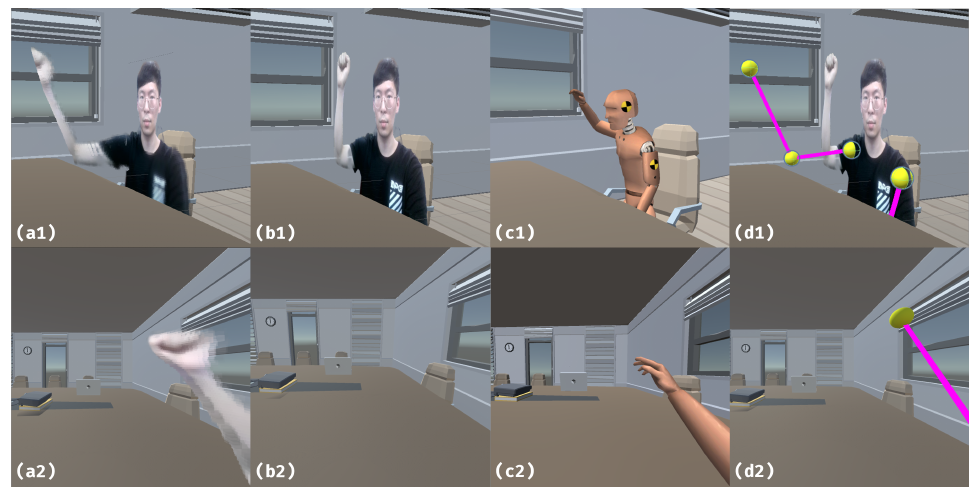
Figure 8. Different methods in the comparative experiments. ( a1 , a2 ) Pixel avatar. ( b1 , b2 ) 2D video conference. ( c1 , c2 ) Artificial avatar. ( d1 , d2 ) Skeleton avatar. The first row is the third-person view, and the second row is the first-person view.